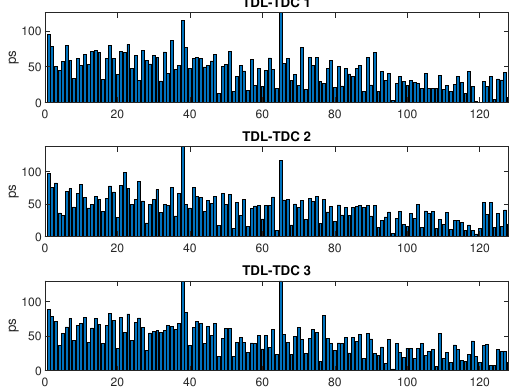
Figure 2. Time distribution for three